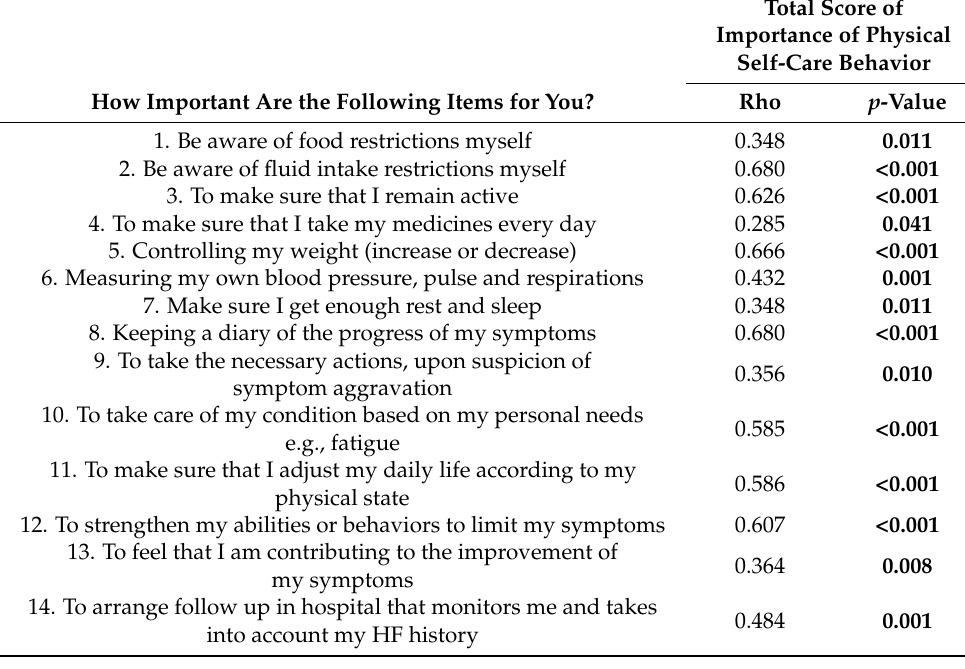
Table 3. Construct validity for 14 item IPSC scale.